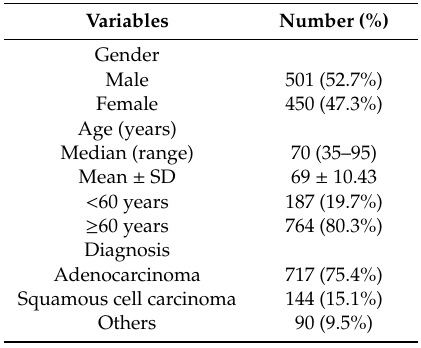
Table 1. Demographic and pathologic features.